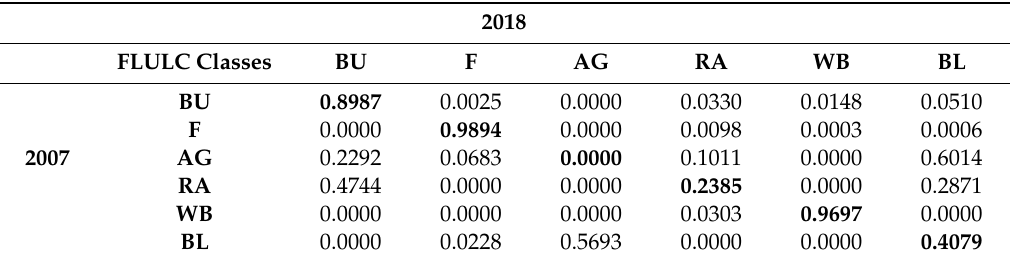
Table 2. Markov chain transition probability matrix (TPM) of land use land cover (LULC) classes in 2018 (simulated) by percentage based on 2007 and 2018 LULC